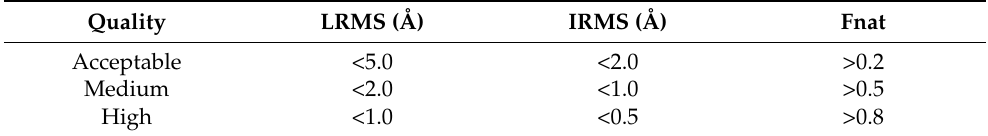
Table 3. CAPRI parameters to assess the peptide quality, IRMS (interface root mean square) LRMS (backbone root mean square) and Fnat (fraction native